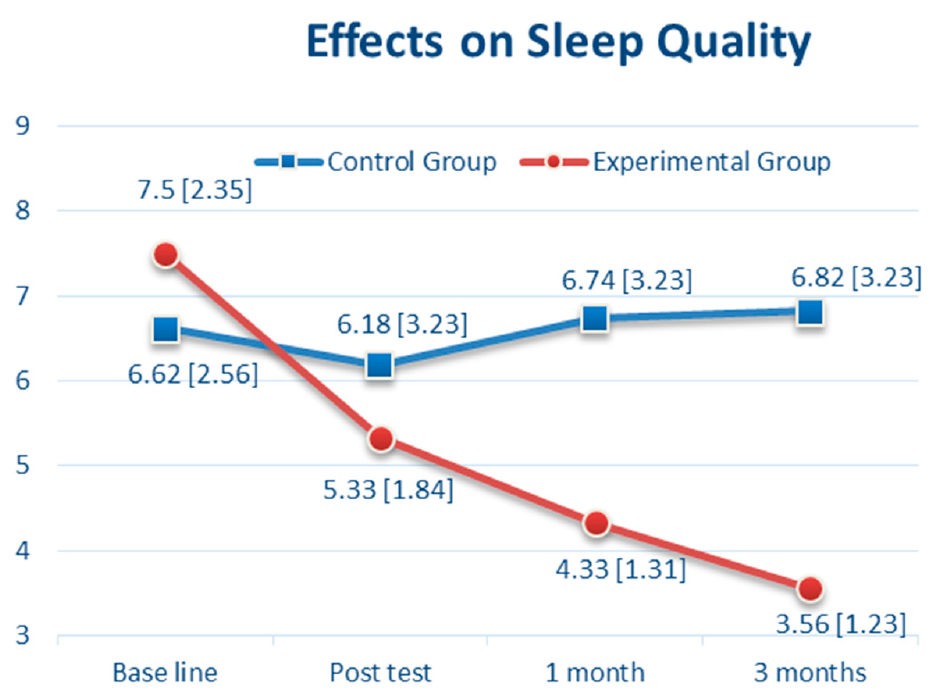
Figure 2. The Effects over Time of Cognitive Behavioral Therapy (CBT) on Sleep